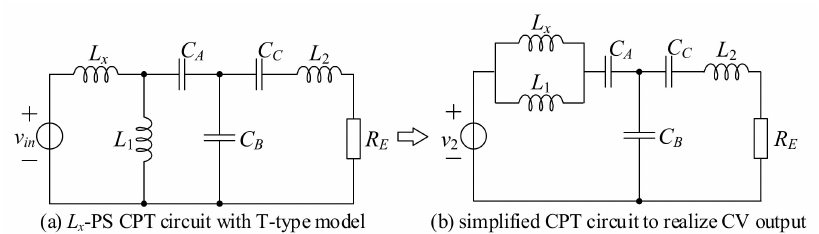
Figure 7. The L x -PS CPT circuit using the T-type model to realize CV output.